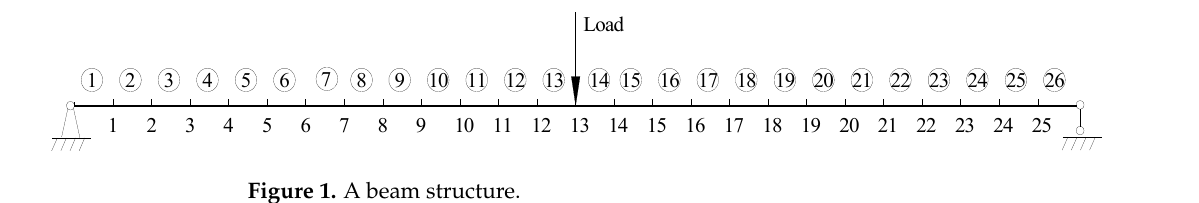
= i δ ' ( 26~1 ) for each element when element 13 is damaged (no noise). i